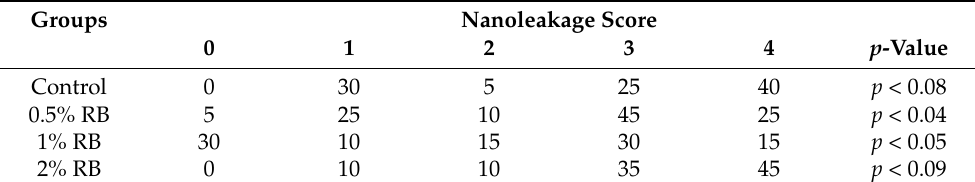
Table 3. Distribution of nanoleakage scores of the five groups of experimental adhesives at baseline. Extent of interfacial nanoleakage 0: 0%; 1: < 25%; 2: 25–50%; 3: 50–75%; 4: > 75%. Cochran–Mantel–Haenszel test (2 × 2 × 5).